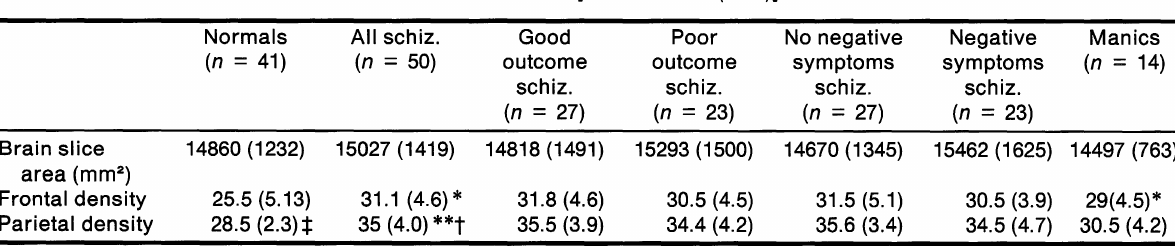
= = = = = 3/101: *F 10.1, P 0.0005; **F 25.8, P 0.0005. = = = = 4.3, P 0.001;:j: t 3.7, P